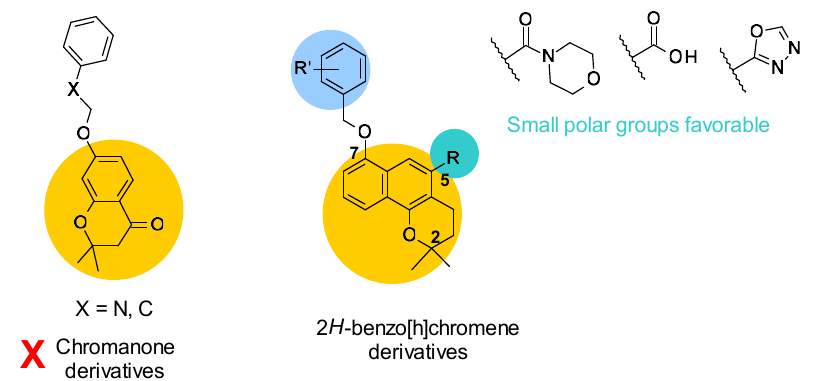
Figure 8. SARs summary for 2 H -benzo[h]chromene